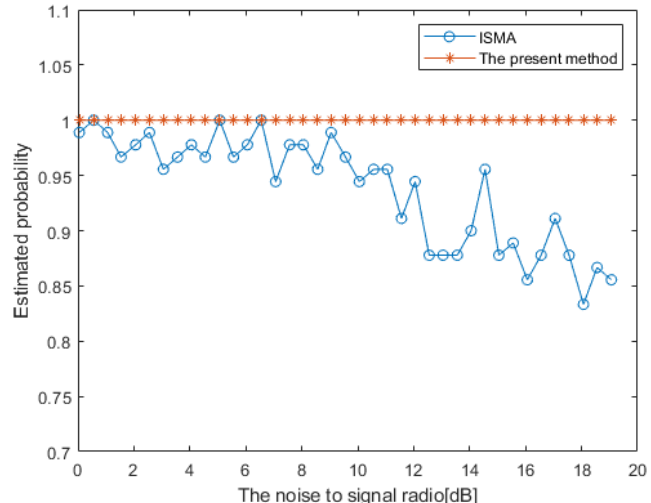
Figure 3. Estimated probability of the two methods under different